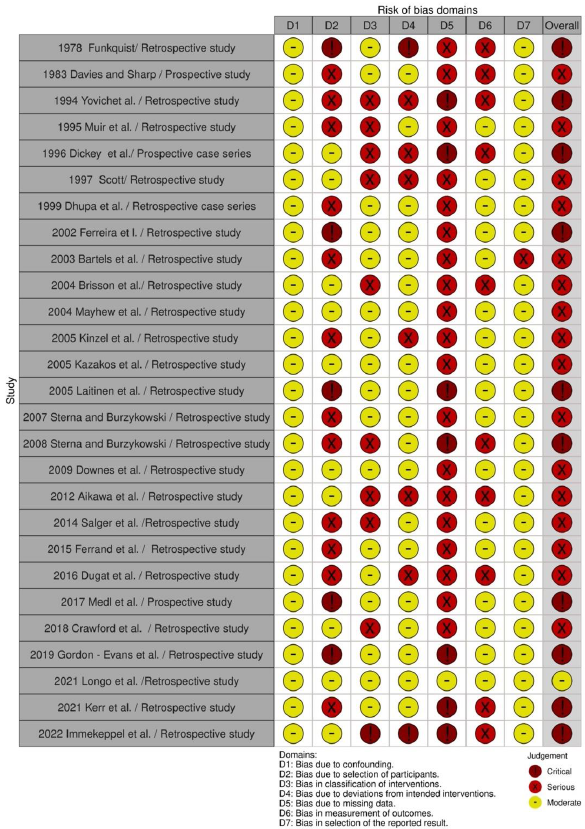
Figure 2. Traffic-light plot of cohort studies.